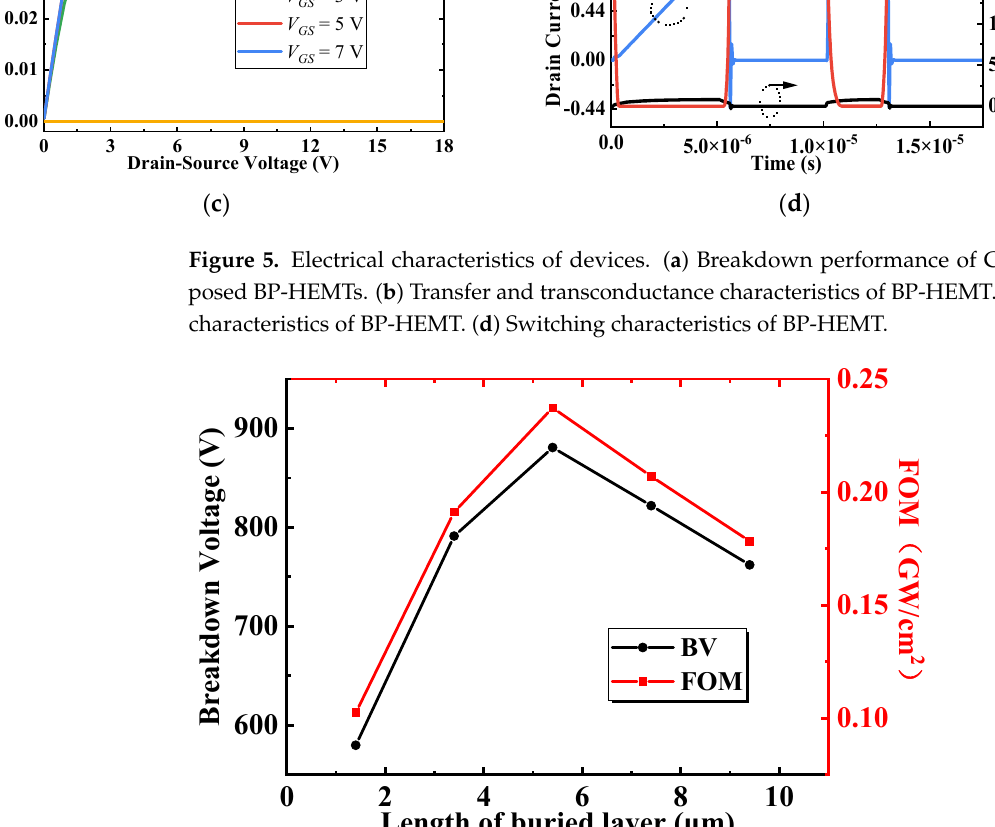
( b ) Figure 7. ( a ) The off-state lateral electric field distribution with different L bl . ( b ) The integral of the electric field along the X -axis with different L bl . Figure 8 shows the variation in T bl (the thickness of the buried layer) on the BV and FOM of the proposed BP-HEMT. Apparently, BV and FOM first increased and then de- creased as T bl increased. When T bl reaches 1.675 μ m, BV and FOM reach maxima of 1098